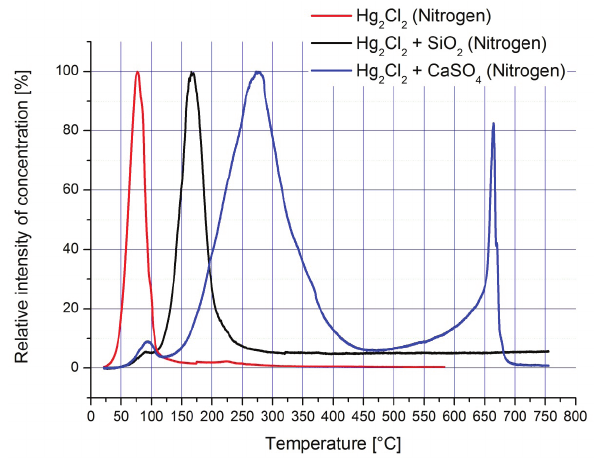
Cl , purged with nitrogen. 2 2